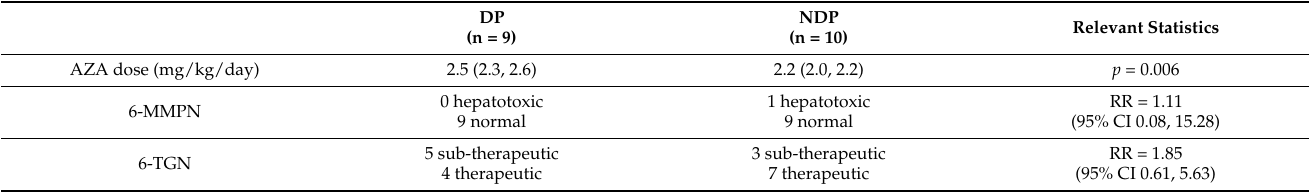
Table 3. Relative risk ratio (RR) and confidence interval (CI) of therapeutic, sub-therapeutic,